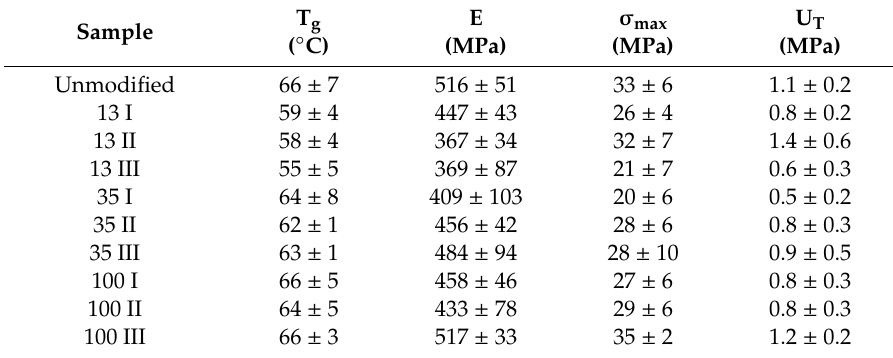
ultimate tensile strength and tensile